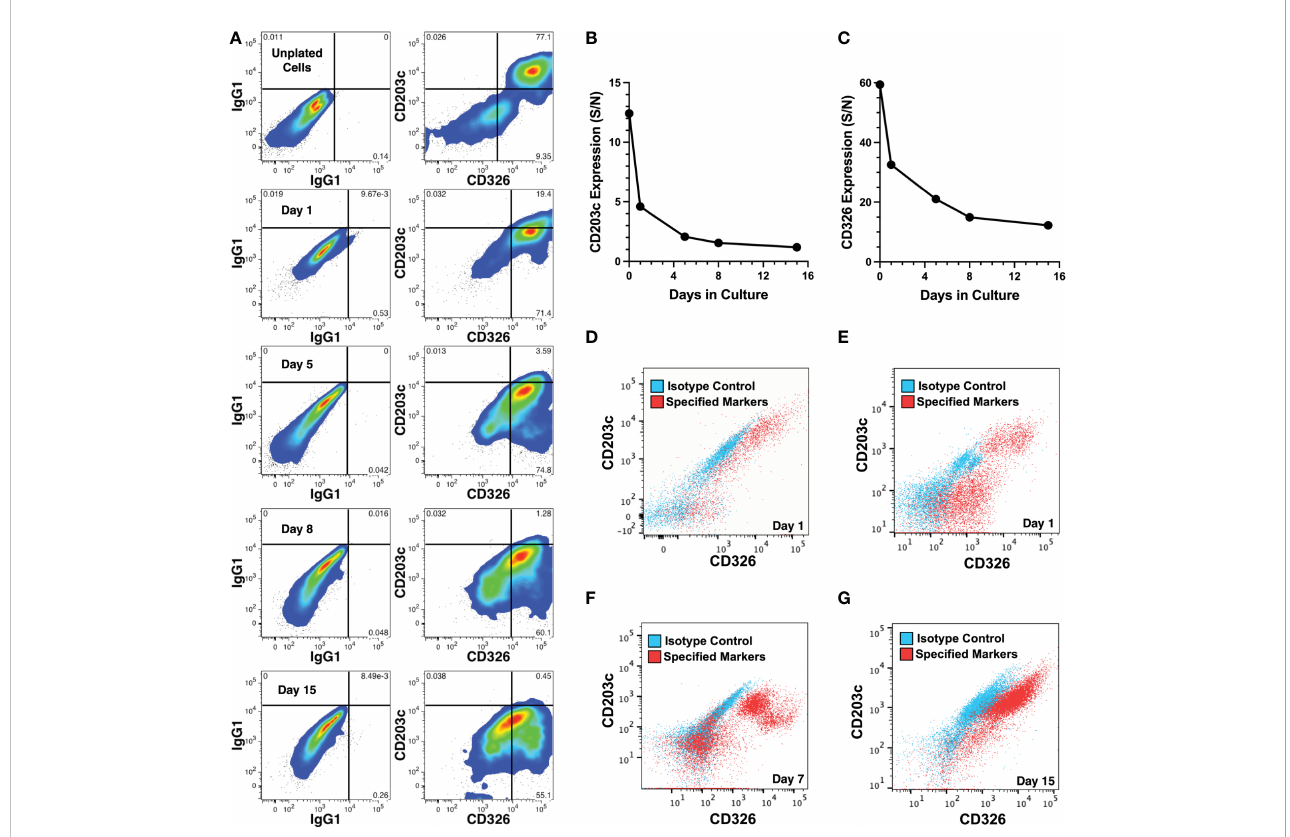
FIGURE 6 Changes in CD203c and CD326 expression during cell culture. (A) CD203c and CD326 expression shown on CD45 - liver cells from a 23 weeks ’ gestation specimen stained before and 1-15 days after culture. (B) Expression of CD203c represented as a signal (CD203c) to noise (IgG1) (S/N) ratio of mean fl uorescence intensities for the data in (A) . (C) Expression of CD326 represented as a S/N ratio of mean fl uorescence intensities for the data in (A) . Erythrocyte depleted liver cells, 21 (D) and 22 (E) weeks ’ gestation, cultured for 1 day and adherent cells analyzed for CD203c and CD326 expression on CD45 - cells. (F) Marker expression analyzed after 7 days of culture of the 22 weeks ’ gestation specimen. (G) CD203c + CD326 ++ cells, isolated from an 18 weeks ’ gestation liver by cell sorting, were cultured for 15 days. CD203c and CD326 expression are shown in red and background staining with isotype matched antibodies is overlaid in blue (D – G) . Cultures for all 4 experiments used William ’ s E